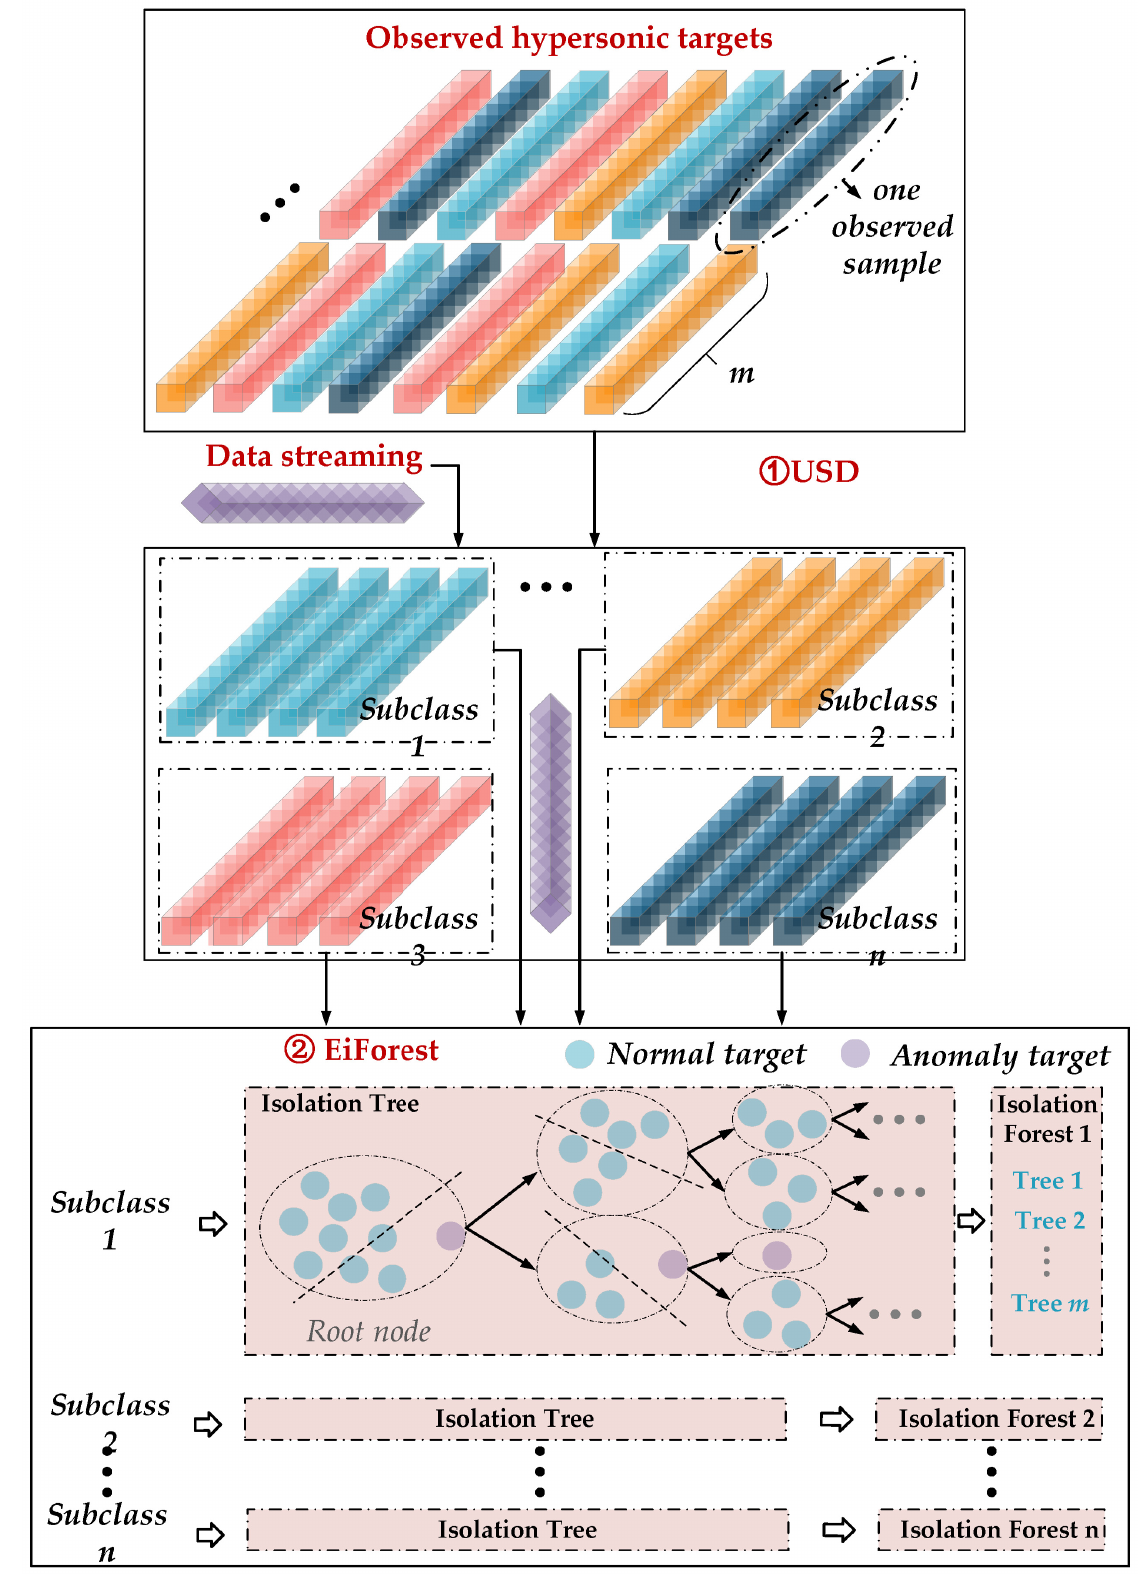
Figure 8. The proposed USD-EiForest method for